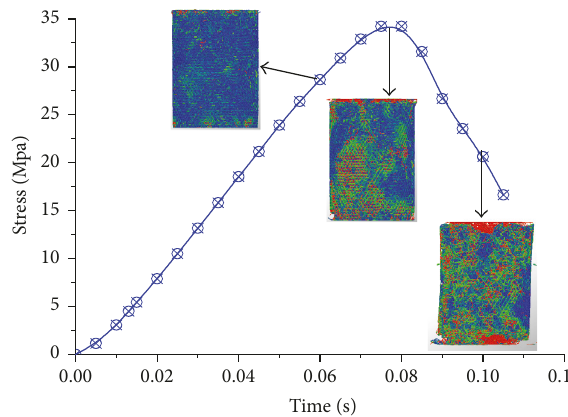
Figure 4: The stress history of the quasi-static test for the concrete DEM